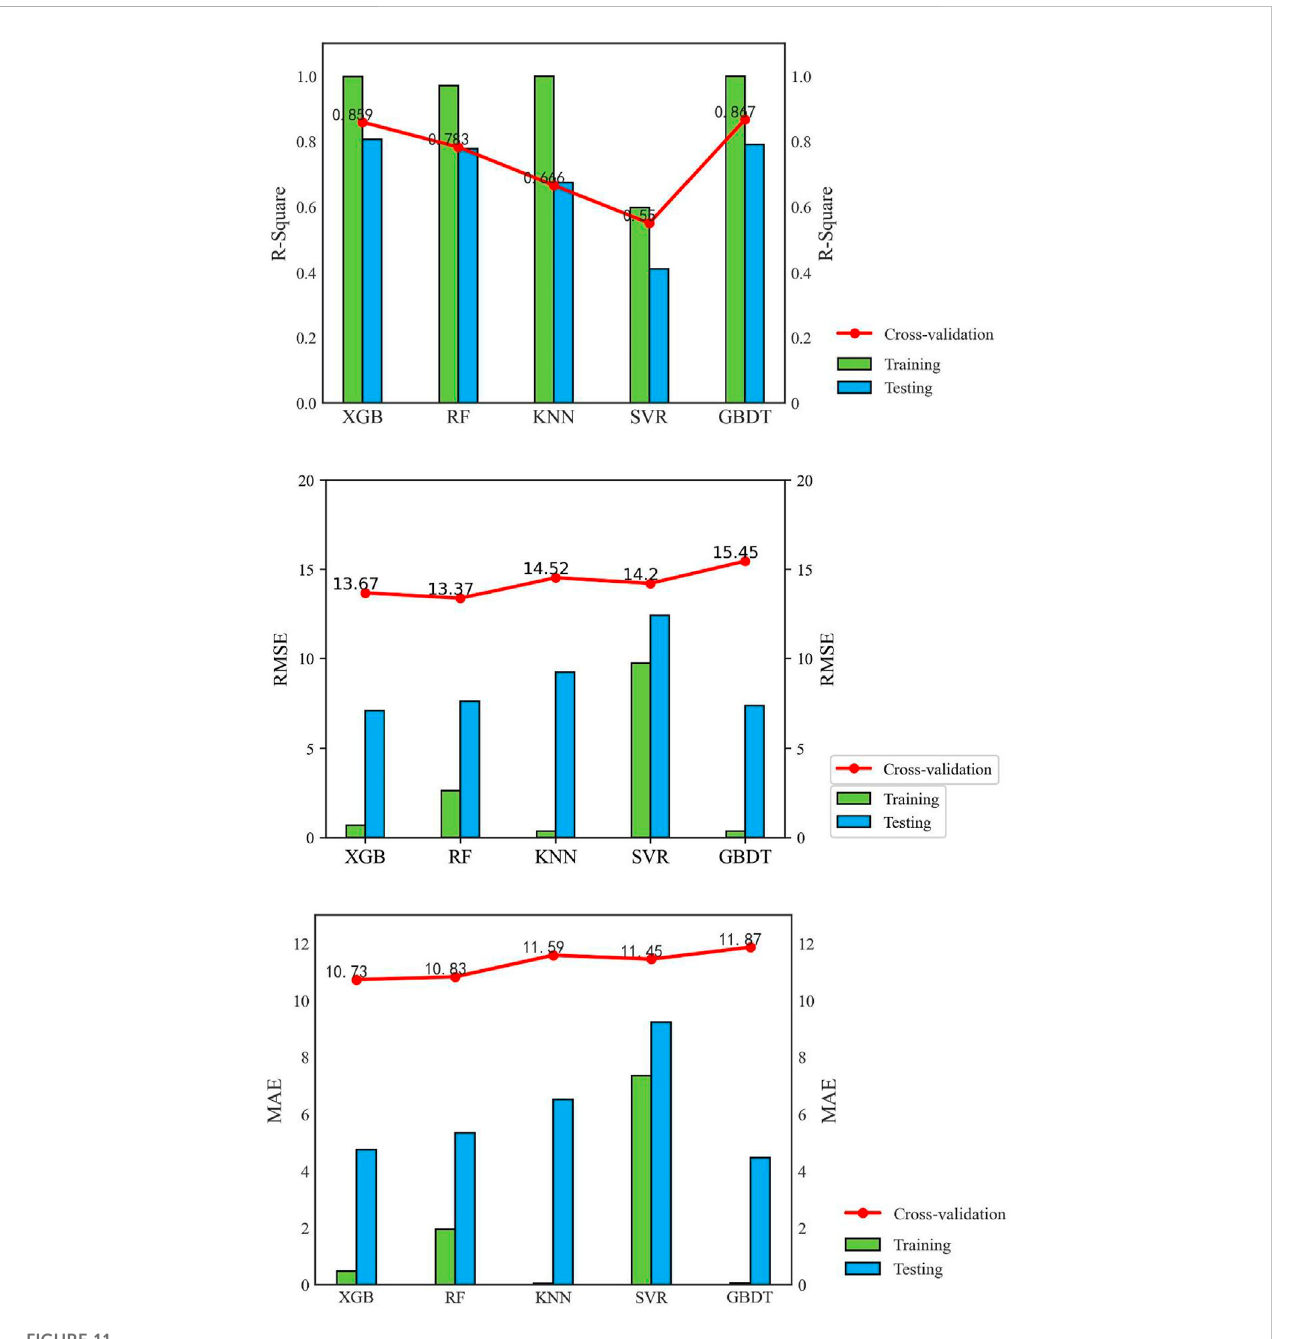
FIGURE 11 Comparison of model prediction